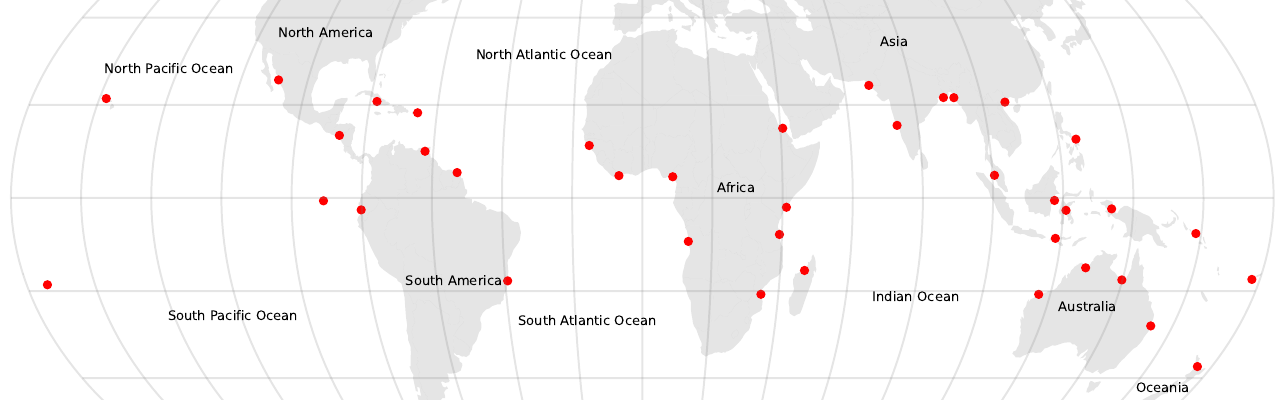
Figure 8. Site locations for assessing the accuracy of the mangrove changes.